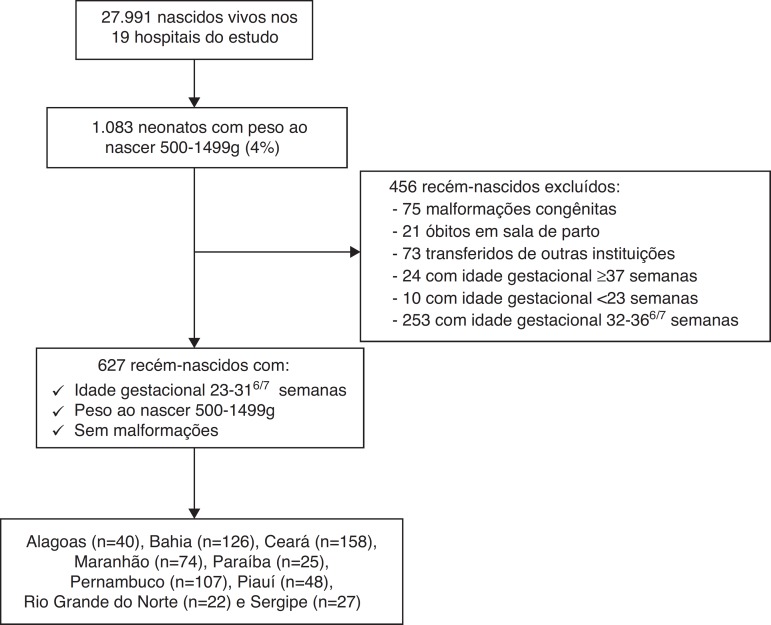
Recém-nascidos que compuseram a amostra do estudo com base no banco de dados da pesquisa da Rede Norte-Nordeste de Saúde Perinatal (Renospe) 2007.